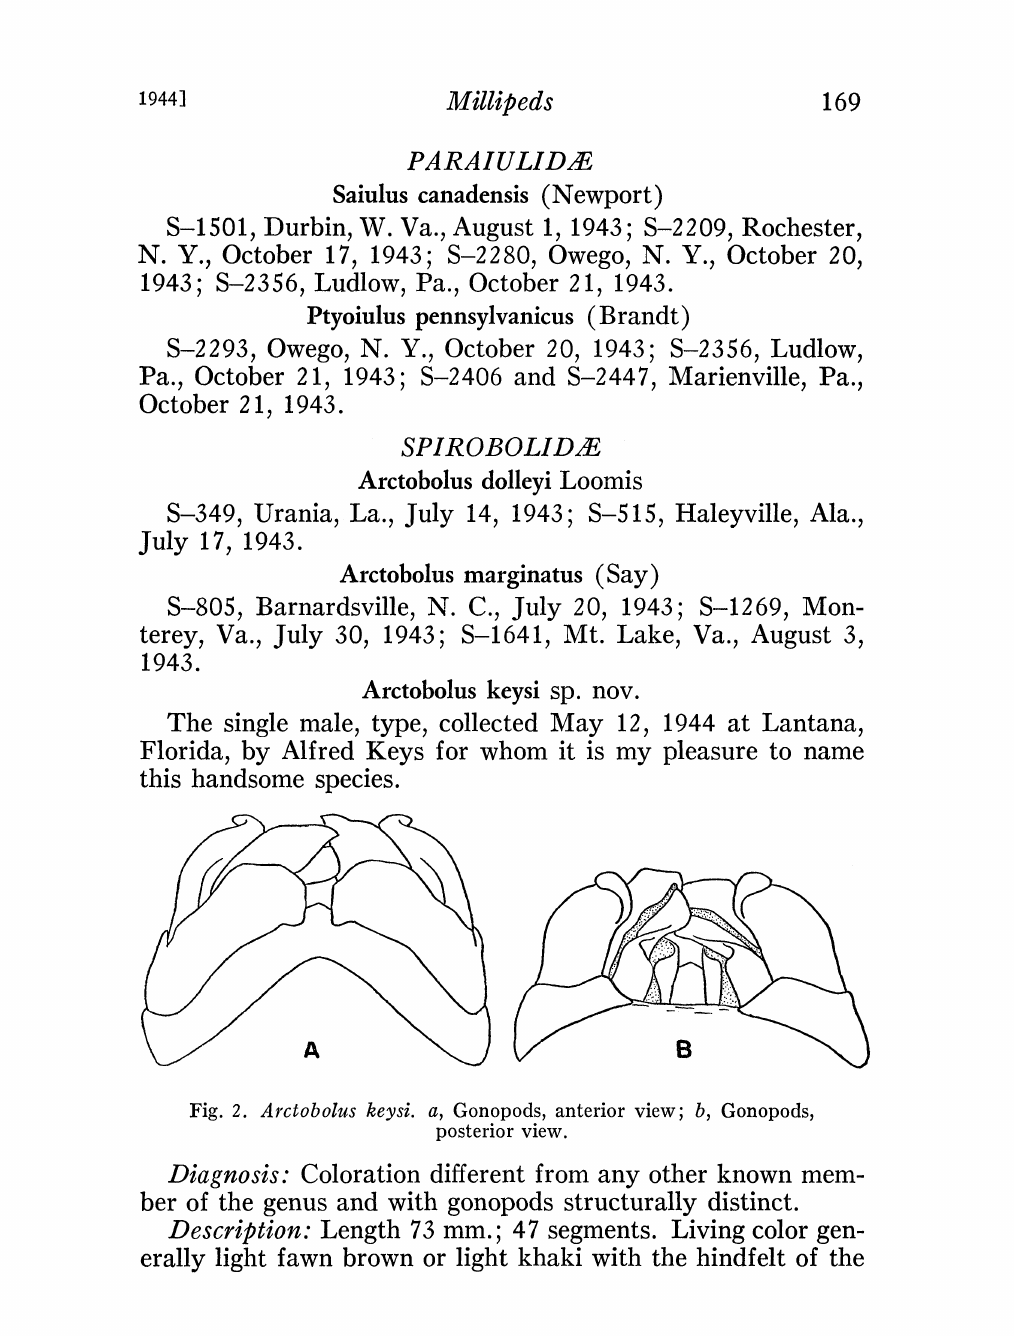
Fig. 2. Arctobolus keysi, a, Gonopods, anterior view; b, Gonopods, posterior view. Diagnosis" Coloration different from any other known mem- ber of the genus and with gonopods structurally